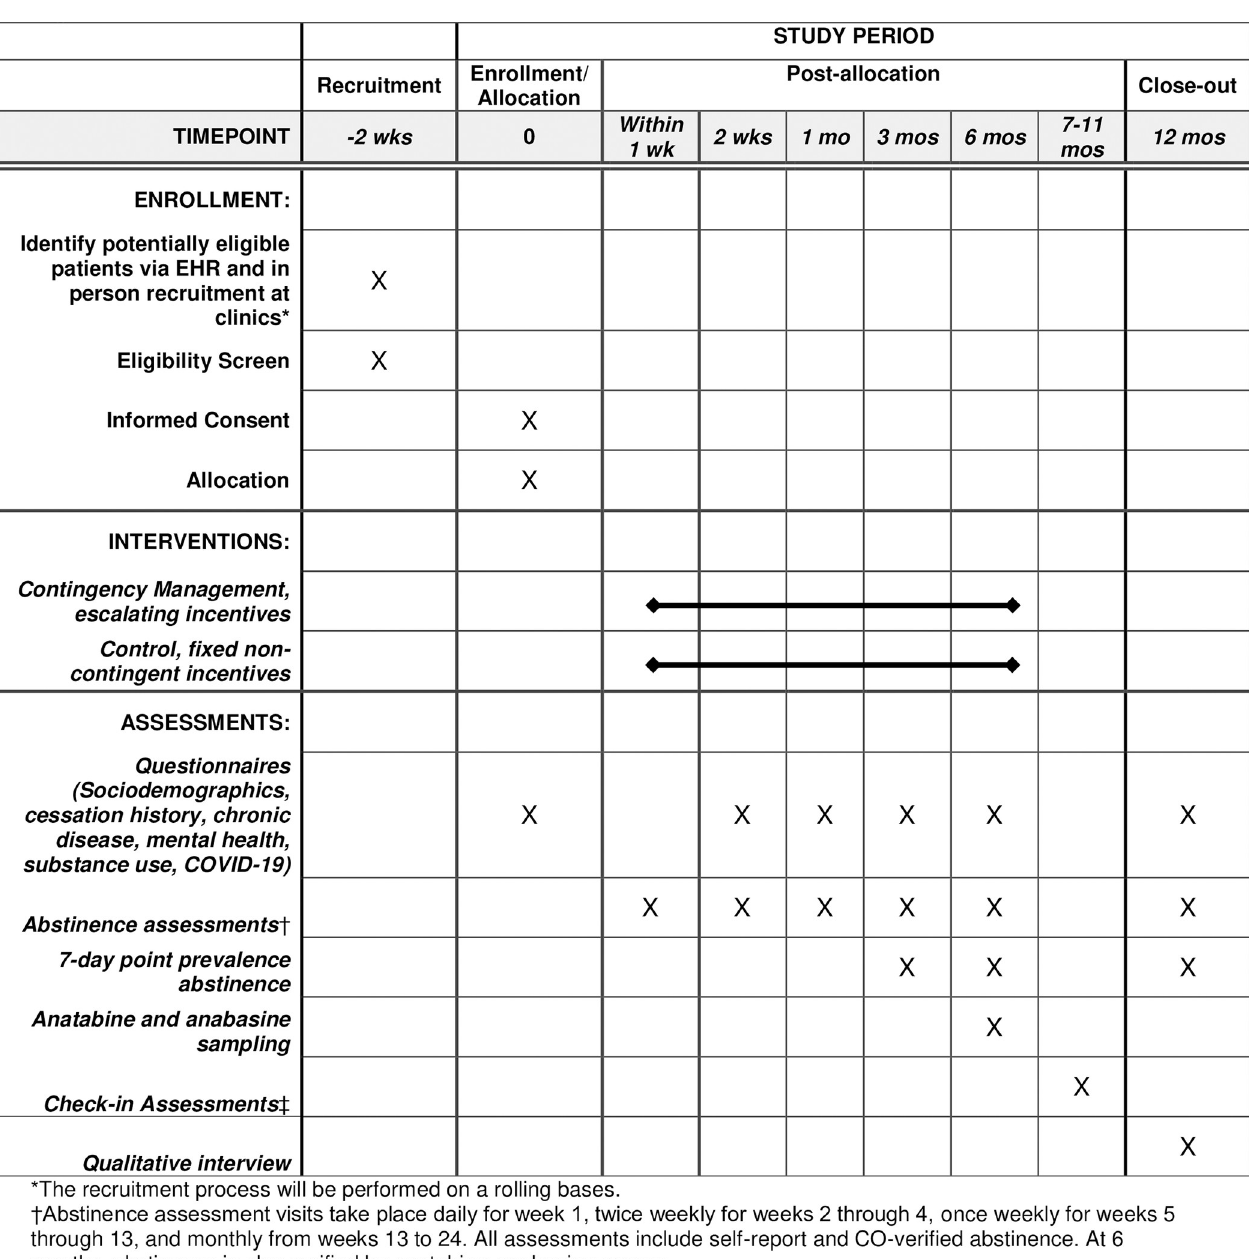
Fig 1. Schedule of enrollment, intervention, and